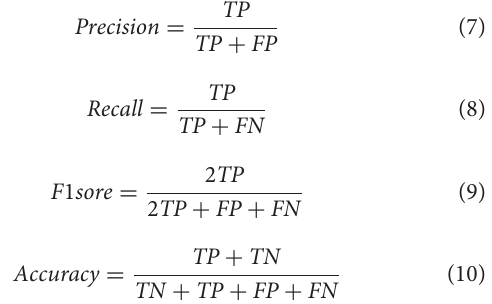
Frontiers in Plant Science |